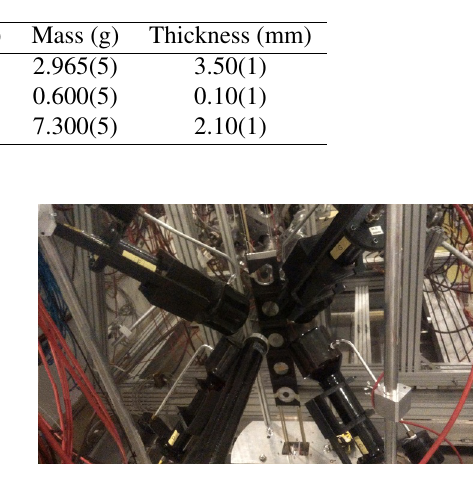
Table 1. Disk shaped samples of 20 mm diameter used during the 80 Se(n, γ ) ToF experiment. Dummy is not included.